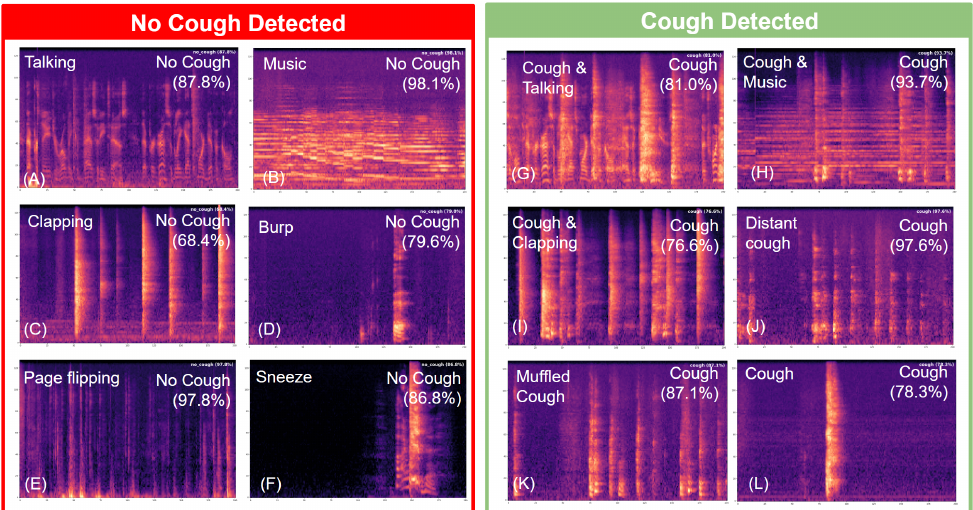
Figure 7. Screenshots of the live demonstration of the cough detection module based on the new spatio-temporal machine learning model. The real-time application, implemented on a laptop computer, captures user-generated sounds using it’s integrated microphones, converts the sound into spectrogram images, processes through the STAIN model to detect the presence of cough, and displays the results on the screen. The x -axis of the spectrogram represents time and the y - axis represents frequency such that each pixel represents a different intensity of sound of a certain frequency at a specific time; lower intensities are represented as black to purple pixels, and higher intensities are represented as red to yellow. The text within each subfigure’s top-left corner describes the sounds played within the spectrogram, and the top-right text details the network prediction and